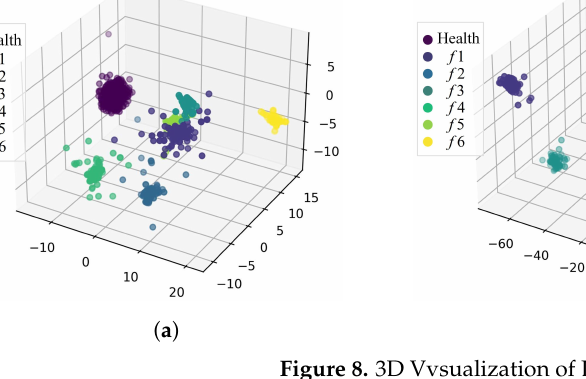
Figure 8. 3D Vvsualization of LDA. ( a ) Unprocessed data. ( b ) Feature data obtained from SD-FAE. ( c ) Feature data processed by